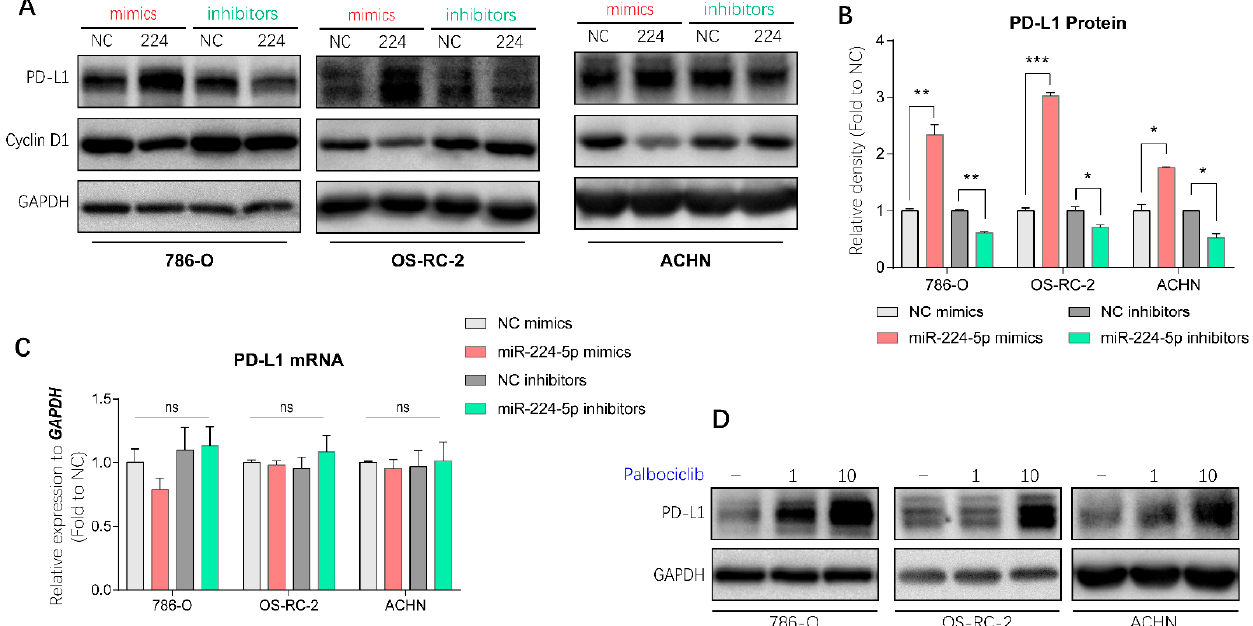
Figure 6. miR-224-5p involved in the regulation of PD-L1 protein in RCC cells by inhibiting cyclin D1 expression. ( A , B ) PD-L1 protein abundances in RCC cells were detected by Western blot after transfection of miRNA mimics/inhibitors. The relative density of PD-L1 protein is shown as mean ± s.e.m of triplicate experiments. * p < 0.05; ** p < 0.01; *** p < 0.001. ( C ) PD-L1 mRNA levels in RCC cells were determined by RT-qPCR after transfection of miRNA mimics/inhibitors (100 nM). Data are mean ± s.e.m. ns, no significant difference. ( D ) PD-L1 protein abundances in RCC cells were detected by Western blot after treatment of selective CDK4/6 inhibitor palbociclib (1 or 10 μ M) for 48 h. (Original Western blots see Figure S7).